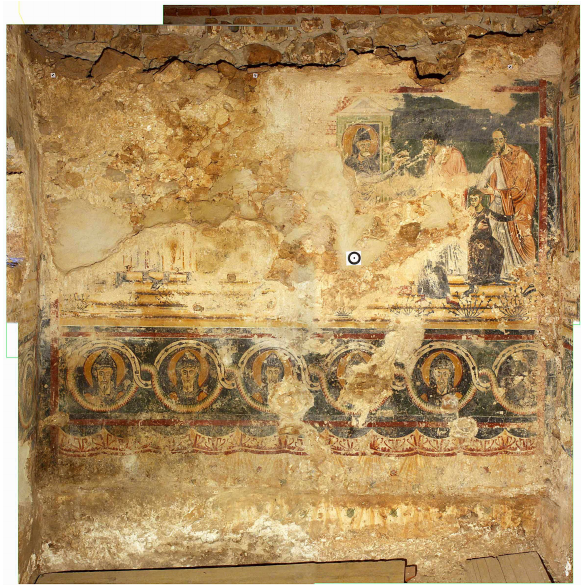
Figure 3. Seeking the position of the Front Nodal Point: center of rotation for panoramic shots. Figure 4. Italy, Fondi, San Magno church, photomap of the northern transept, M. Carpiceci